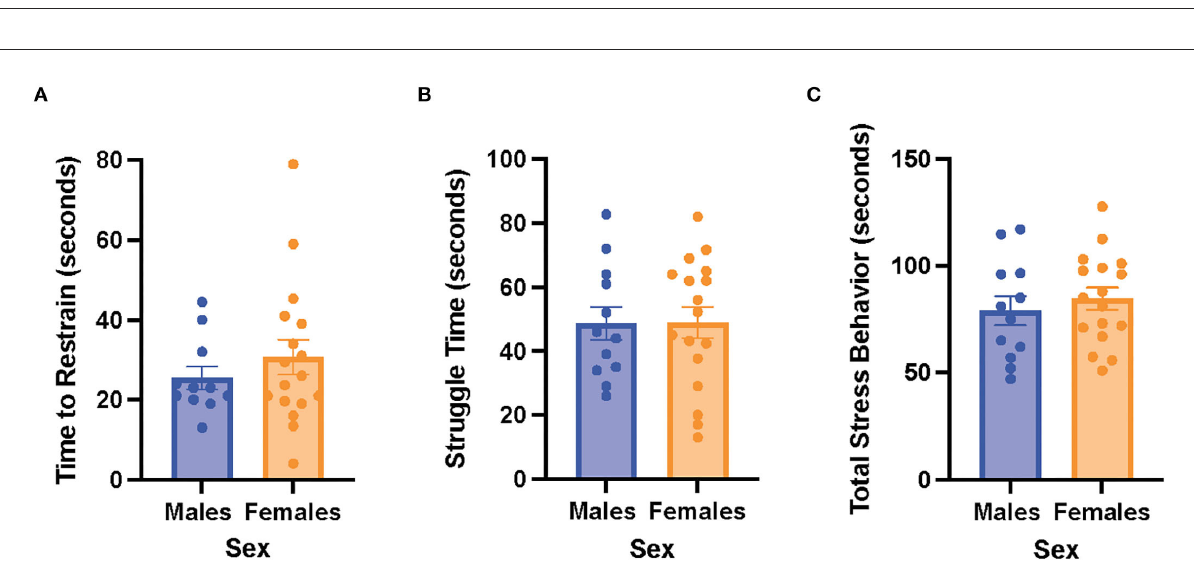
FIGURE3 Male and female rats did not differ in restraint stress behaviors. (A) Time to restrain in the male and female rats. (B) Struggle time in the male and female rats. (C) Total stress behavior in the male and female rats. Independent samples t -tests were conducted to compare the measurements between the mean of males ( n = 12) and the mean of females ( n = 18). Error bars are plotted as mean ±